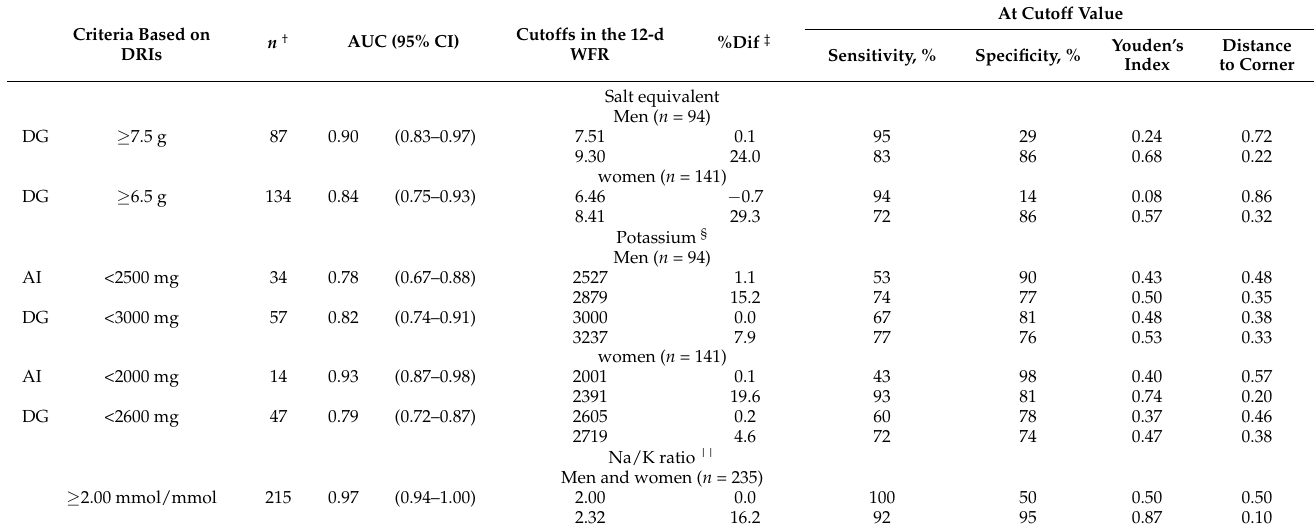
Table 4. Accuracy of estimated salt and potassium intake levels using the 12-day WFR to detect individuals with intake levels that deviated from the DRIs measured using multiple 24-h urinary excretion measurements